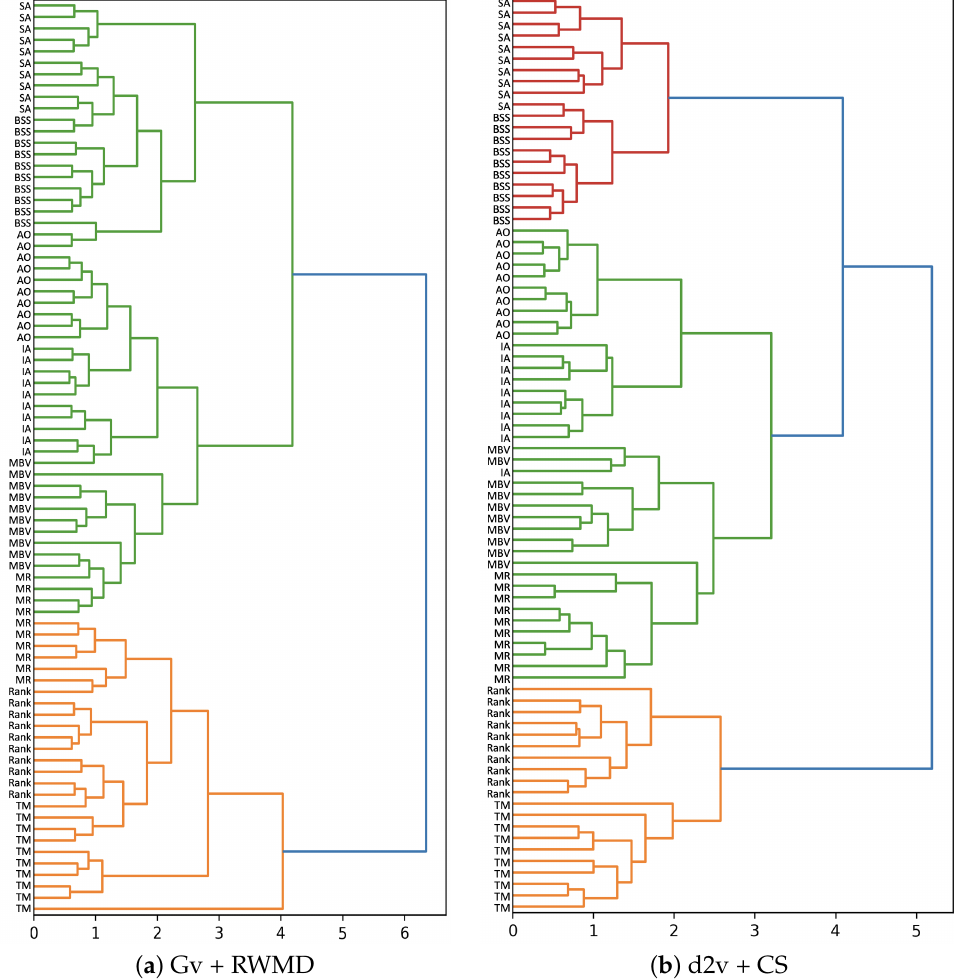
Figure 9. Task II. Clustering using Gv using RWMD as a distance does not improve over Gv and SCS, maybe on the contrary. On the right, we can see d2v + CS, which performs very well in general for all groups, both for small and large clusters. Colors refer to clusters assigned with a threshold automatically determined by the drawing